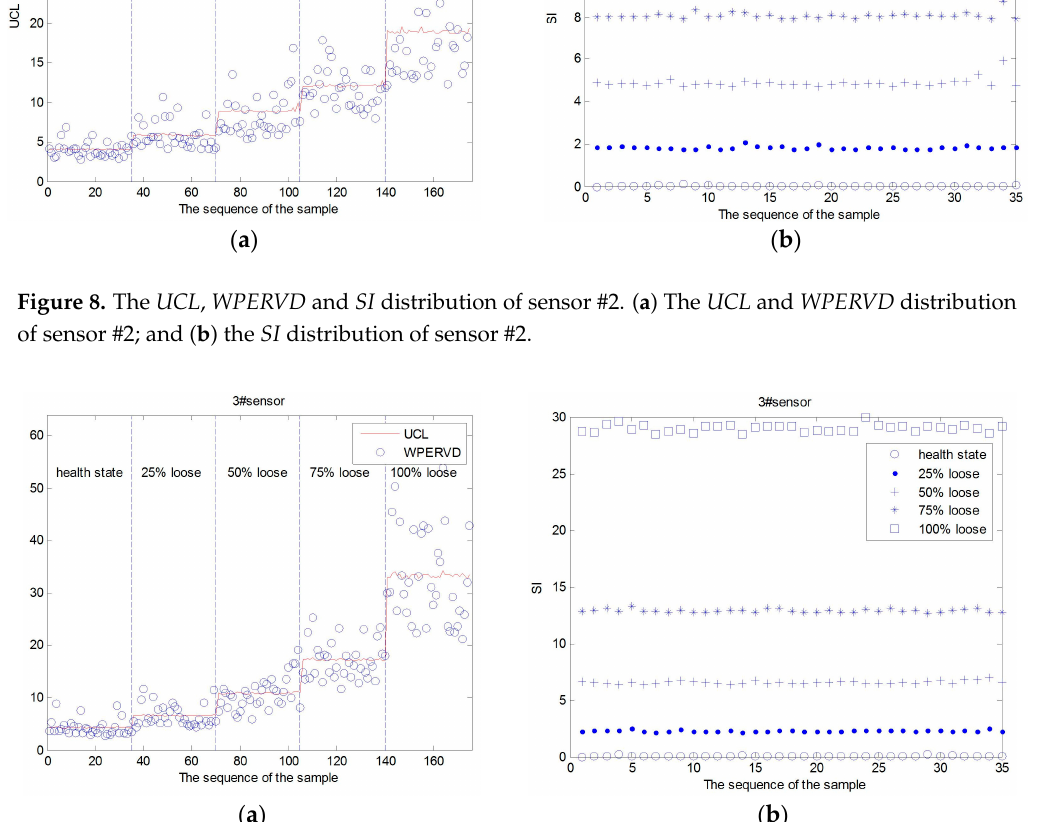
Figure 9. The UCL , WPERVD and SI distribution of sensor #3. ( a ) The UCL and WPERVD distribution of sensor #3; and ( b ) The SI distribution of sensor #3.